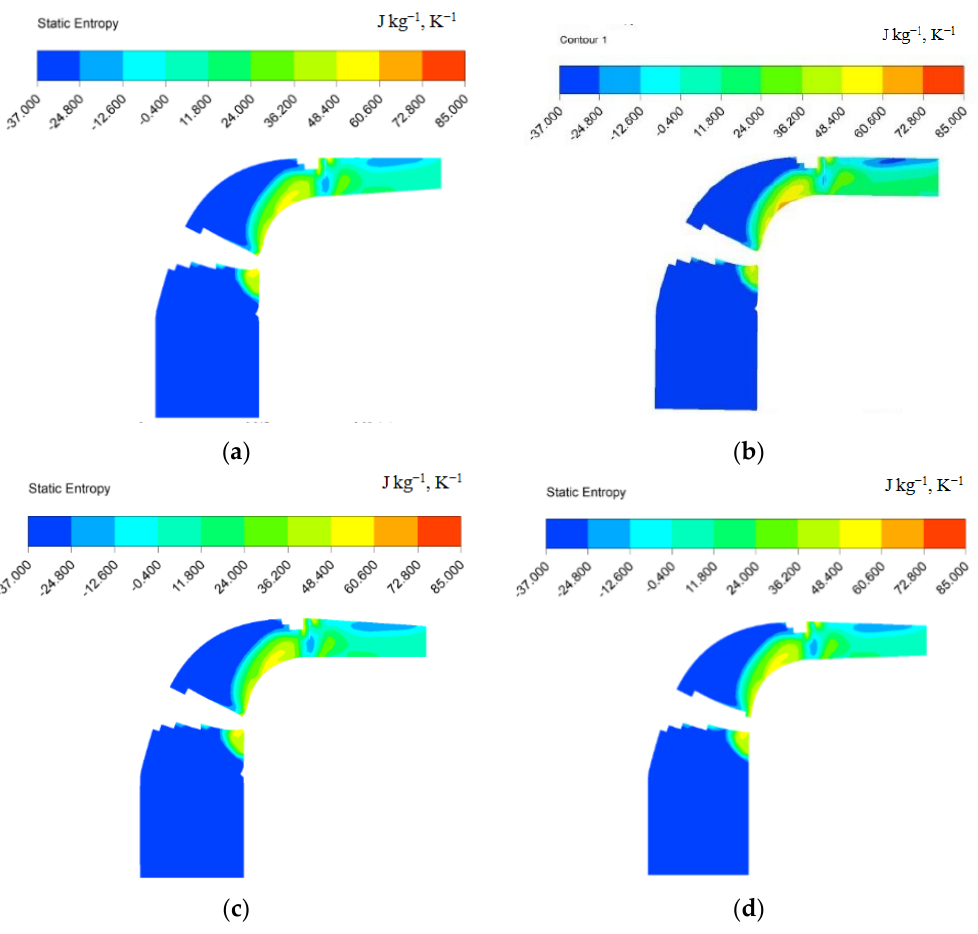
Figure 15. Meridional surface entropy distribution at 1 relative mass flow ( a ) parallel; ( b ) convergence from shroud; ( c ) convergence from hub; ( d ) equal convergence from shroud and hub.